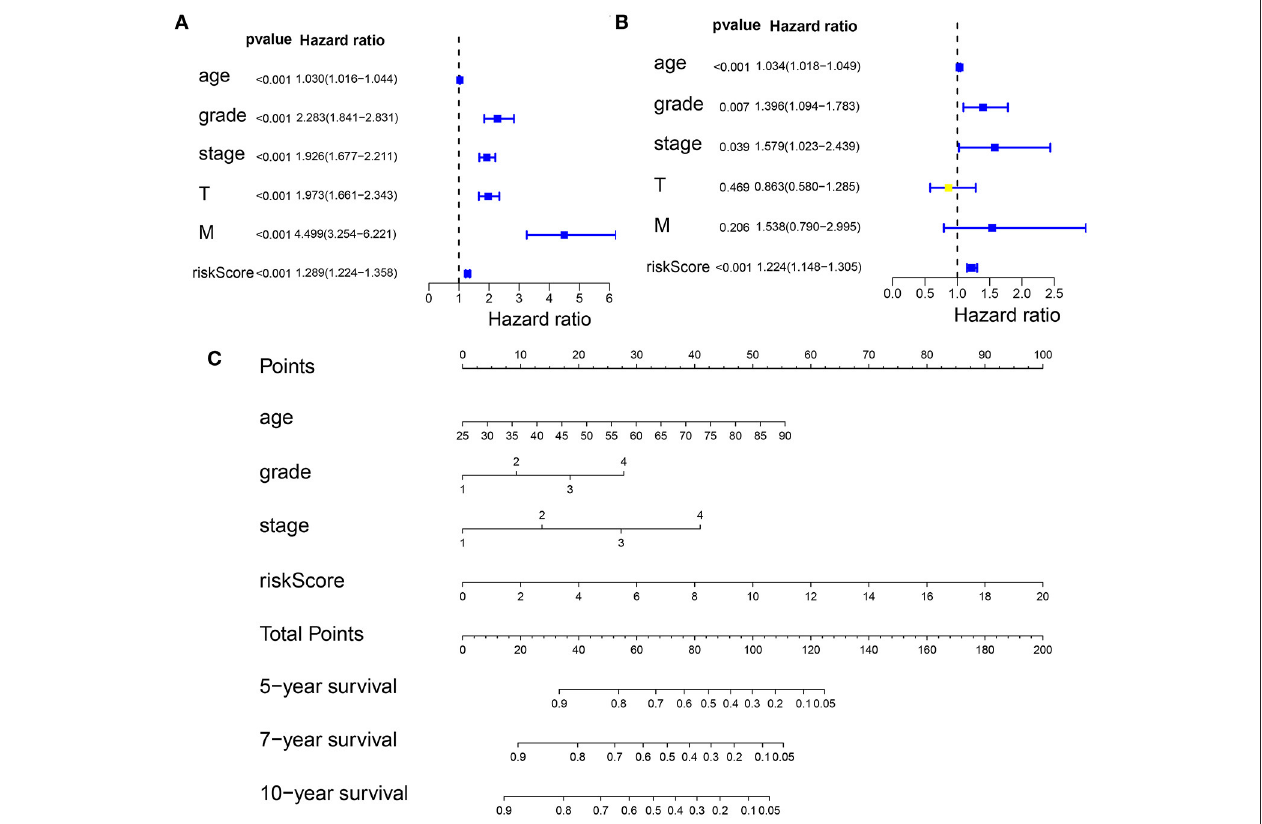
FIGURE 8 | Predicting the outcome of patients with KIRC using a nomogram. (A) The univariate Cox regression analysis of the association among risk score (RS), the clinicopathological parameters [age, grade, stage, tumor size (T), and tumor metastasis (M)] and the overall survival (OS) of the patients with KIRC. The forest plot showed that the age, tumor grade, stage, T, M, and RS correlated with the OS of the patients ( p < 0.05). (B) A multivariate Cox regression analysis of the association among the RS, clinicopathological parameters, and the OS of the patients with KIRC. The forest plot revealed that the patient’s age, grade, stage, and RS were independent risk factors correlated with OS ( p < 0.05). (C) Nomogram drawn by the “rms” package in R Studio incorporated riskScore, age, grade, and stage, which can be used to predict the outcome of patients with KIRC. The second to fifth lines represent the patient’s age, tumor grade, tumor stage, and RS. The total score in the sixth row is the sum of the scores for each item from the second to fifth lines. The 5-, 7-, and 10-year survival rates were predicated based on the total score.